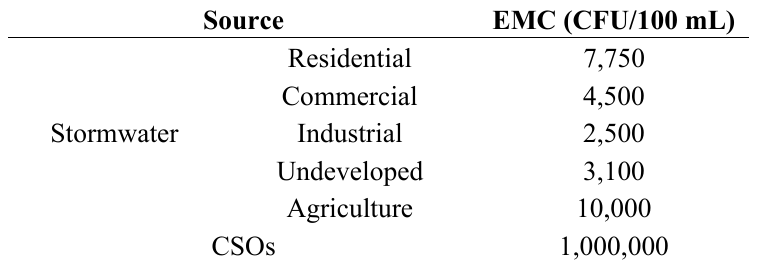
Table 4. Event Mean Concentrations (EMC) values for the different land uses.